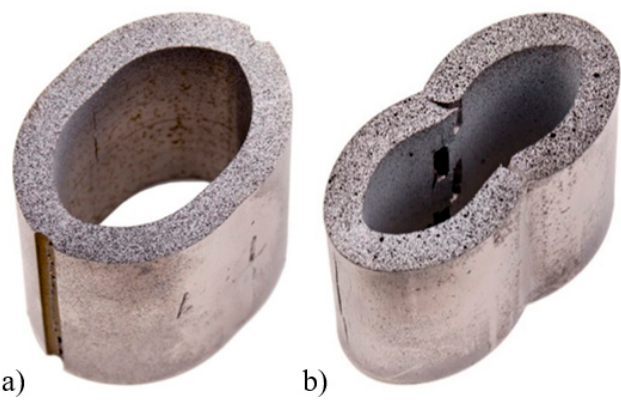
Figure 13. ( a ) Notched and ( b ) unnotched rings after testing.